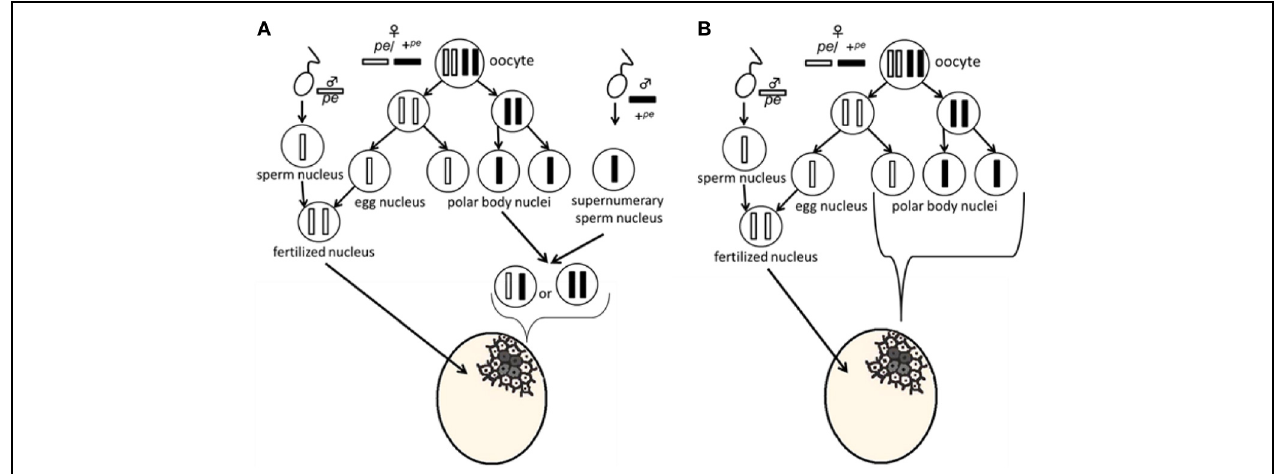
from the fusion of pe sperm and pe egg nuclei, while small black cells result from fusion of a polar body nucleus and one of the supernumerary sperm